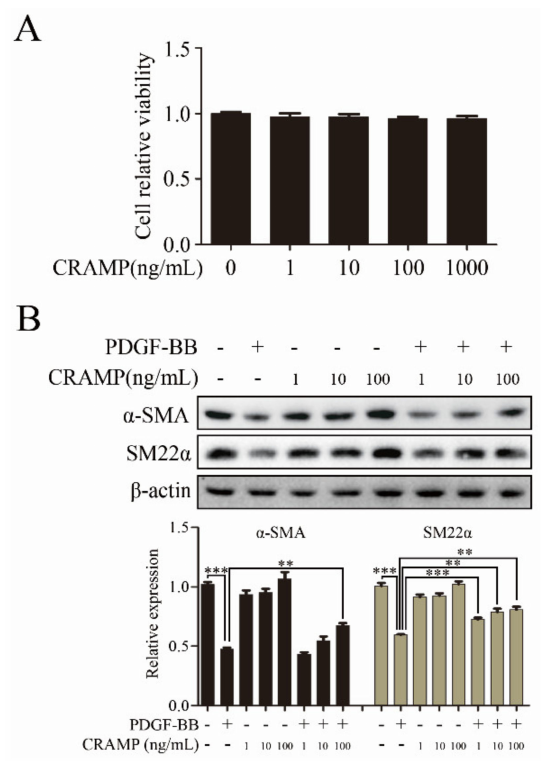
Figure 1. Cathelicidin-related antimicrobial peptides (CRAMP) inhibits platelet-derived growth factor-BB (PDGF-BB)-induced vascular smooth muscle cells (VSMC) Phenotypic transformation. ( A ) Measurement of changes in cell viability of VSMC after 48 h incubation with a range of concentrations (0, 1, 10, 100 and 1000 ng / mL) of CRAMP. ( B ) VSMC were pretreated with CRAMP (100 ng / mL) for 2 h and then stimulated with PDGF-BB (20 ng / mL) for 24 h followed by immunoblotting with α -SMA and SM22 α antibodies. Data of 3 independent experiments is presented as mean ± SEM. ** p < 0.01; *** p < 0.001 compared with